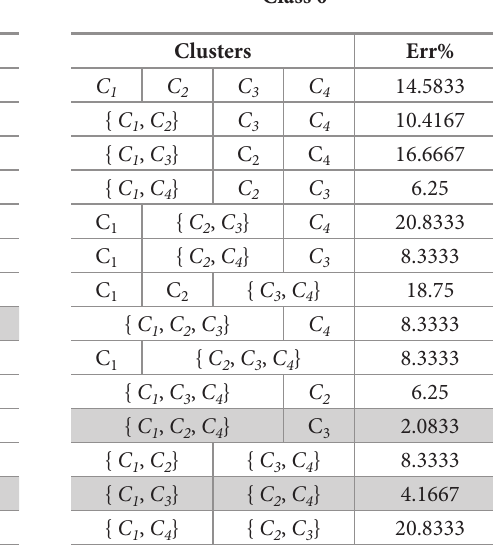
Table 7. Cluster combination classification errors for each class using C4.5. Best combination lines are shadowed